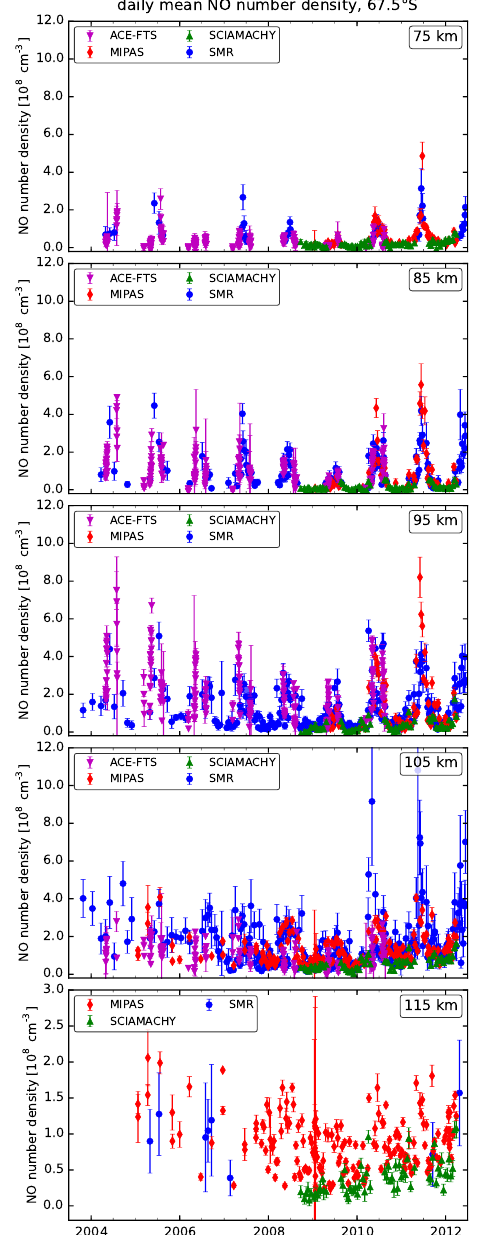
Figure B1. NO time series comparison of all four instruments at 67.5 ◦ N, for 75km, 85km, 95km, 105km, and 115km (from top to bottom).